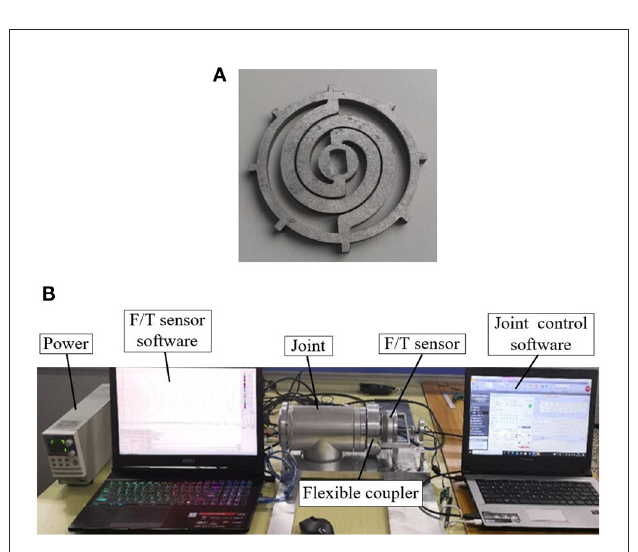
FIGURE9 The setup of experiment. (A) The optimal flexible coupler. (B) Test rig for the flexible coupler.